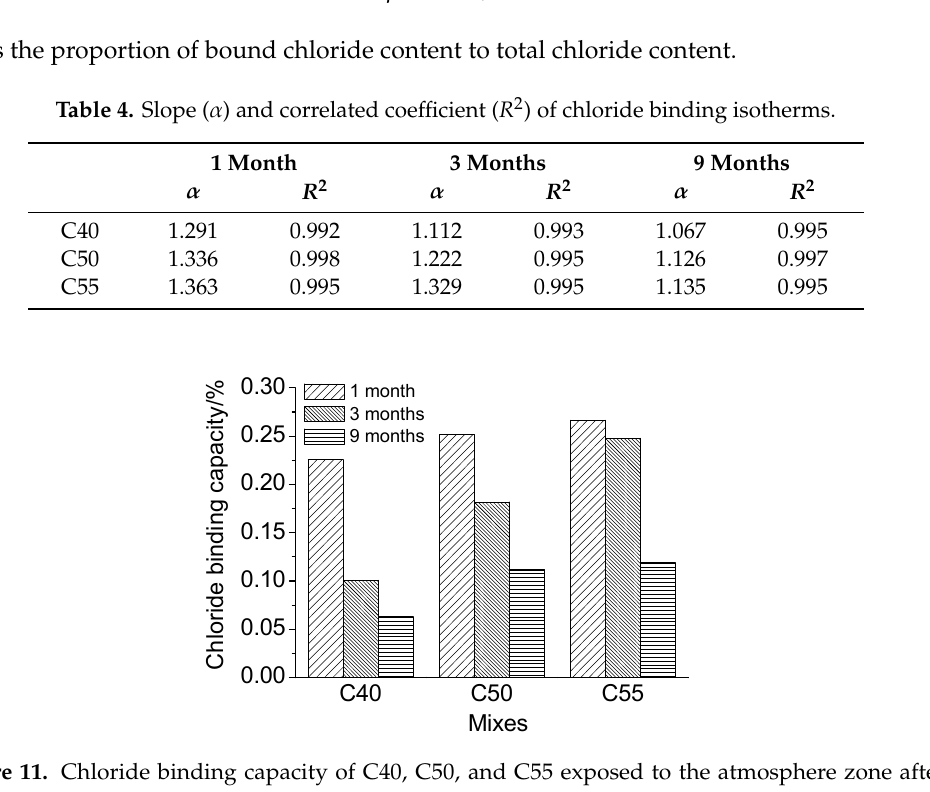
Figure 10. Chloride binding isotherms of C40, C50, and C55 exposed to the atmosphere zone after different times. ( a ) 1 month. ( b ) 3 months. ( c ) 9 months.